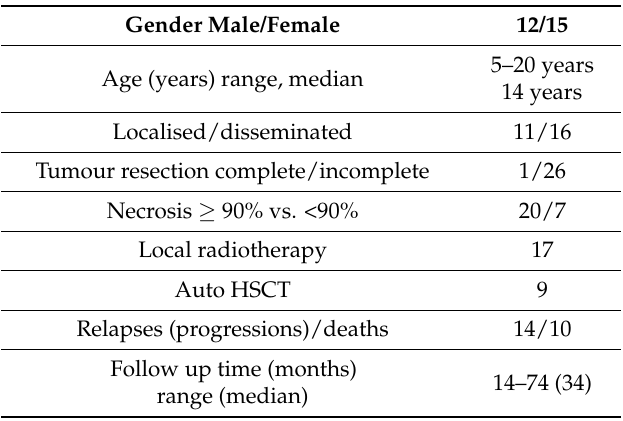
Table 1. The clinical characteristic of patients ( n =